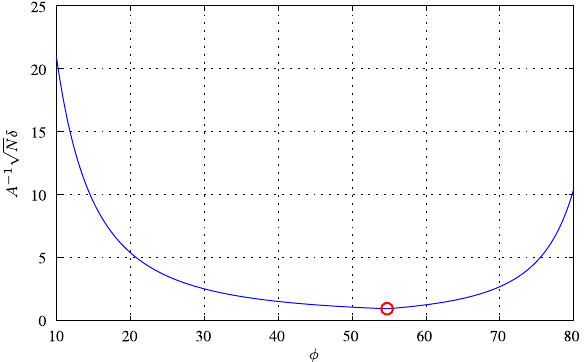
Figure 3. Frame bounds dependent on the angle φ (for N = 10). The red circle indicates the minimum for φ tight = arcsin